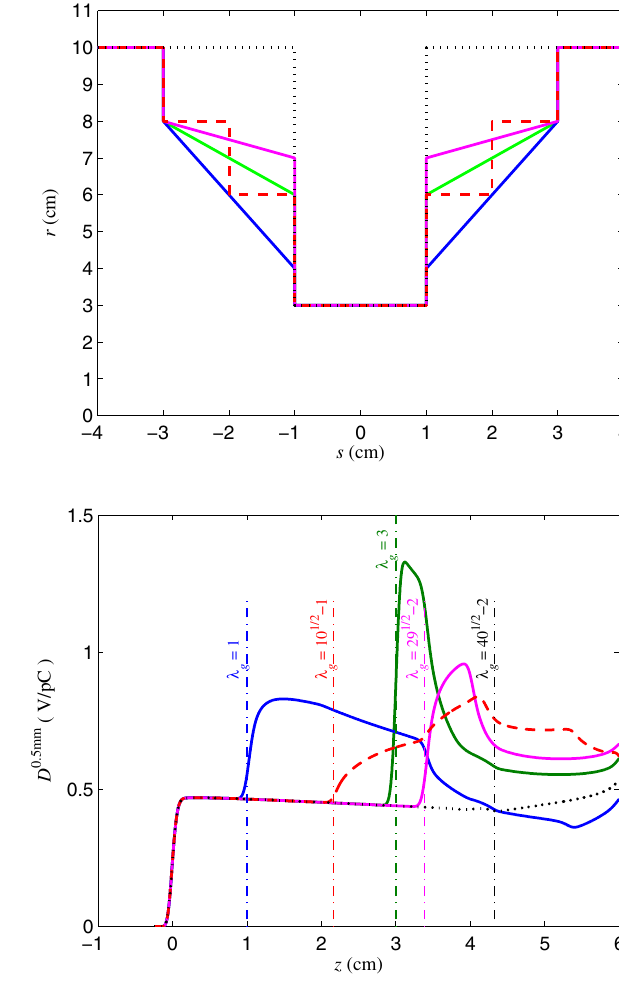
FIG. 5. (top) Geometries for a set of collimators; (bottom) functions D 0 : 5 mm ð z Þ calculated with ECHO .